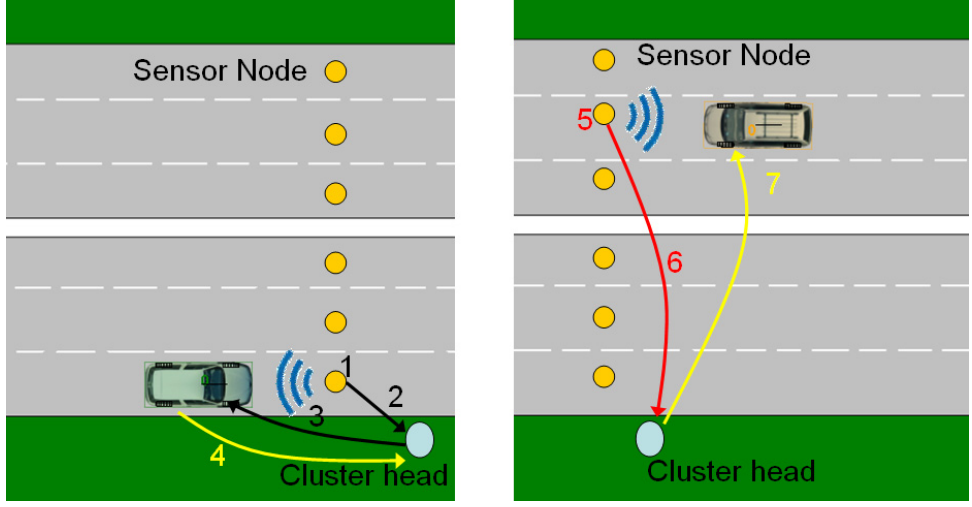
Figure 5. VANET-centric application. Data Interchange between disconnected vehicles: (1) source vehicle detection, (2) notification to Cluster Head, (3) data request to vehicle, (4) data reply (stored at the Cluster Head), (5) destination vehicle detection, (6) notification to Cluster Head, (7) data delivery to destination